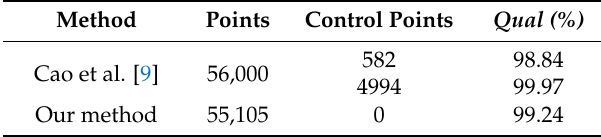
Table 7. Comparison of accuracy results based on the fandisk